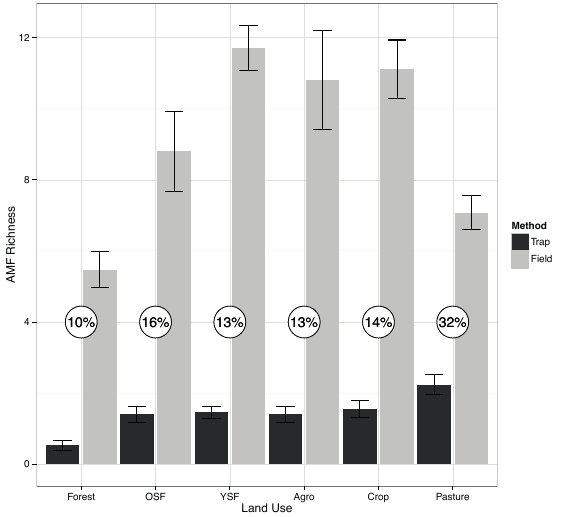
Figure 1 – Mean AMF species richness per sample detected by spores recovered from fi eld (grey bars) or trap culture (black bars). The numbers inside white circles indicate the effi ciency of trap culture (expressed as percentage) for detecting the morphotypes recovered by fi eld sampling. Error bars represent the standard error of the mean (n = 17 for Forest; n = 10 for OSF; n = 30 for YSF; n = 10 for Agroforestry; n = 18 for Crop; n = 13 for Pasture).